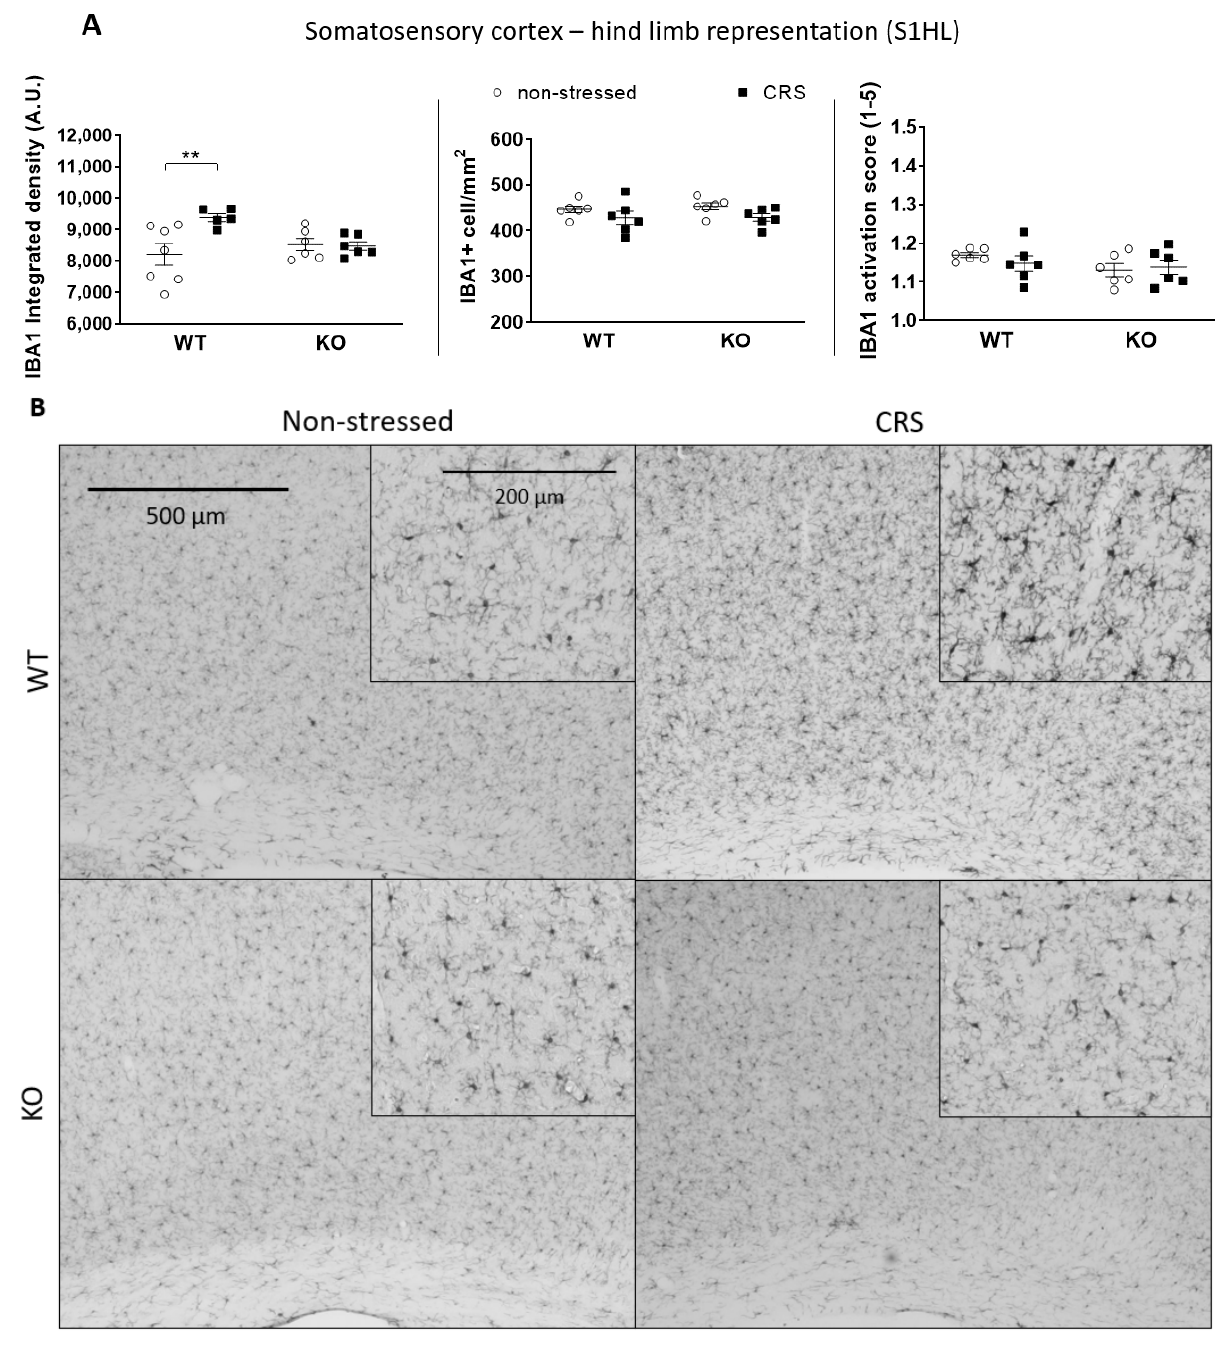
Figure 7. Diagrams show the ionized calcium-binding adaptor molecule 1 (IBA1) integrated density, the number of IBA1+ cells and the IBA1 activation score of microglia examined in the somatosensory cortex–hind limb representation part (S1HL—( A )). Representative images show the IBA1+ microglia cells in S1HL ( B ). Chronic restraint stress (CRS), Wild-type (WT), Interleukine-1 knock-out (KO). Data are presented as the means ± SEM of n = 5–7 animals with individual plots; two-way analysis of variance (ANOVA), followed by Tukey’s tests; ** p < 0.01 vs. respective group.